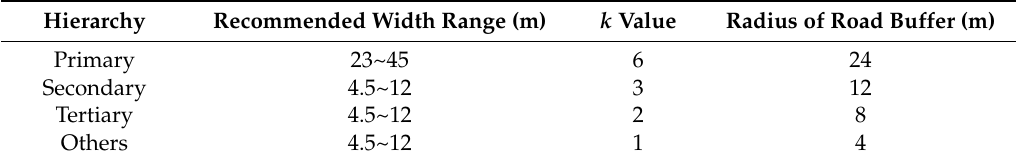
Table 1. Determined radii of road buffer with different